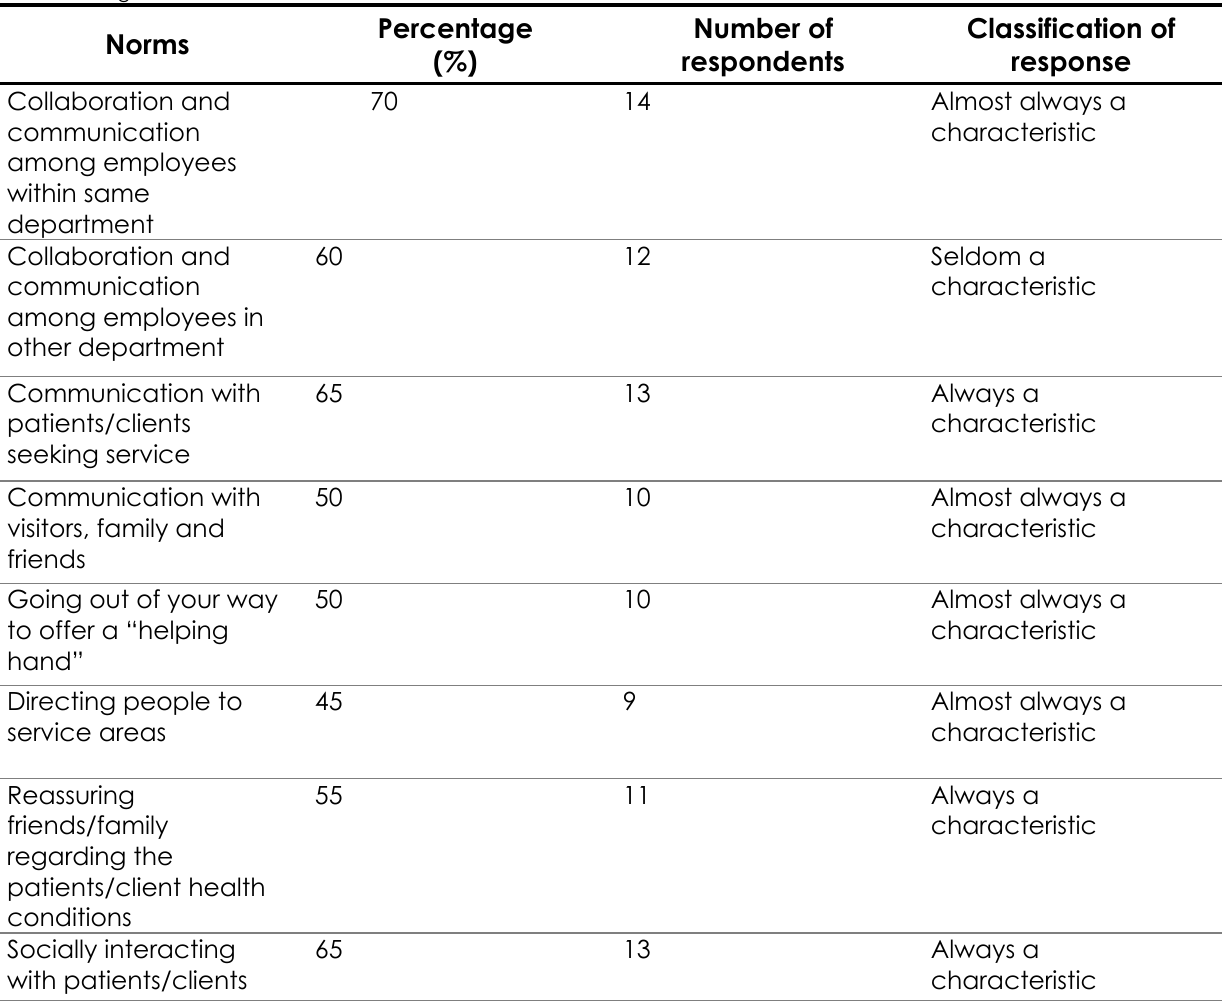
Table 3. Rating of norm at EMU health centre